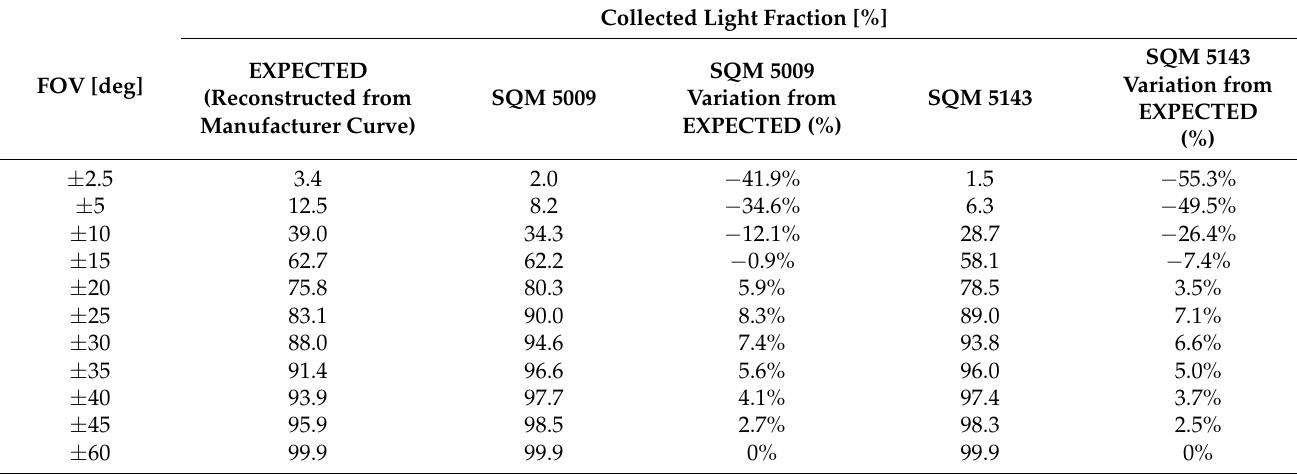
Collected Light Fraction [%]